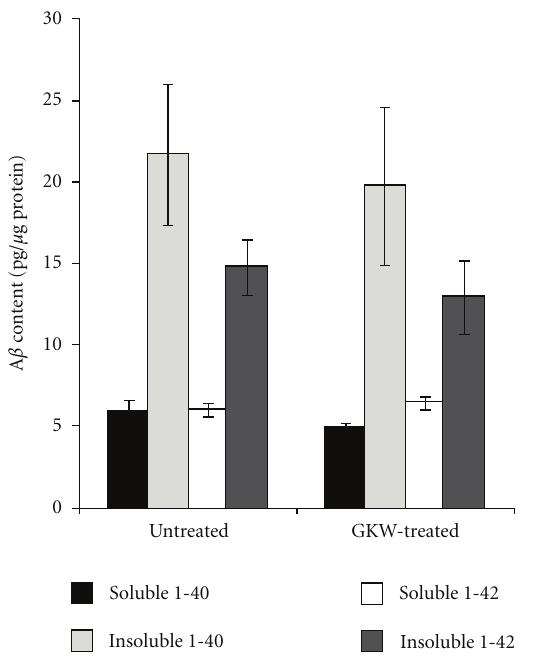
Figure 3: Soluble and insoluble A β in cortical tissue from treated and untreated mice. Mean values ± SEM are shown. Treated and untreated Tg2576 mice did not di ff er significantly in levels of any of the measured isoforms of A β .